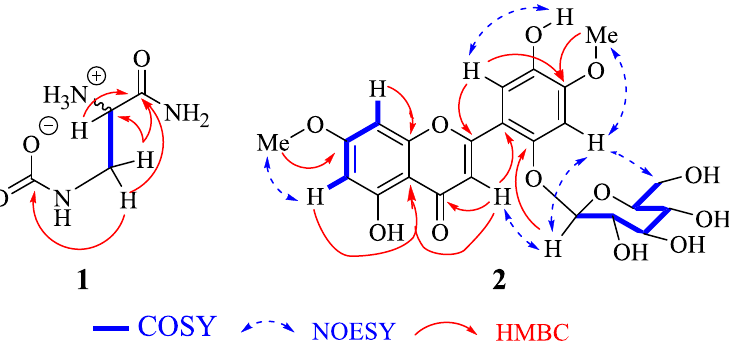
Figure 2. COSY, HMBC, and NOESY correlations of compounds 1 and 2 . Table 1. 13 C and 1 H-NMR spectroscopic data ( 1 H 600 MH Z , 13 C 150 MH Z for compounds 1 (in D 2 O) and 2 (in DMSO- d 6 ).